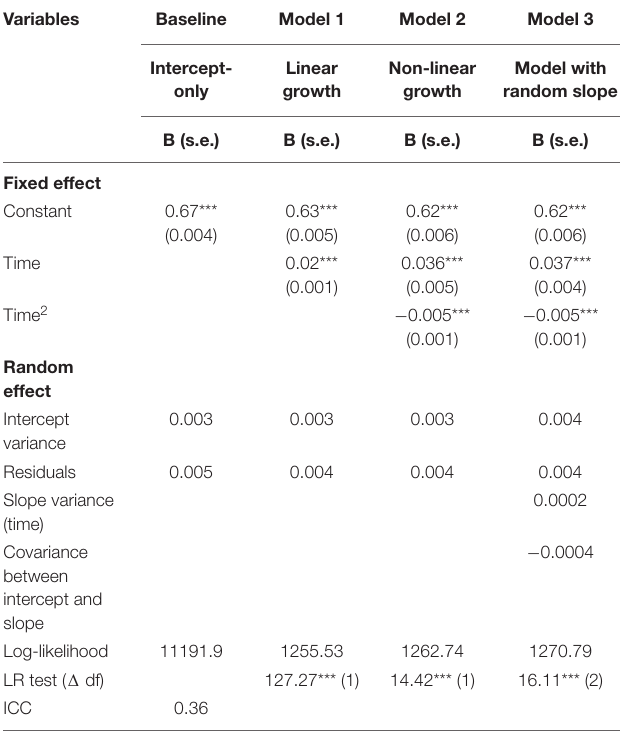
TABLE 4 | Cohort 1: results of ME growth models for changes in ANS accuracy from grade 1 to grade 5.